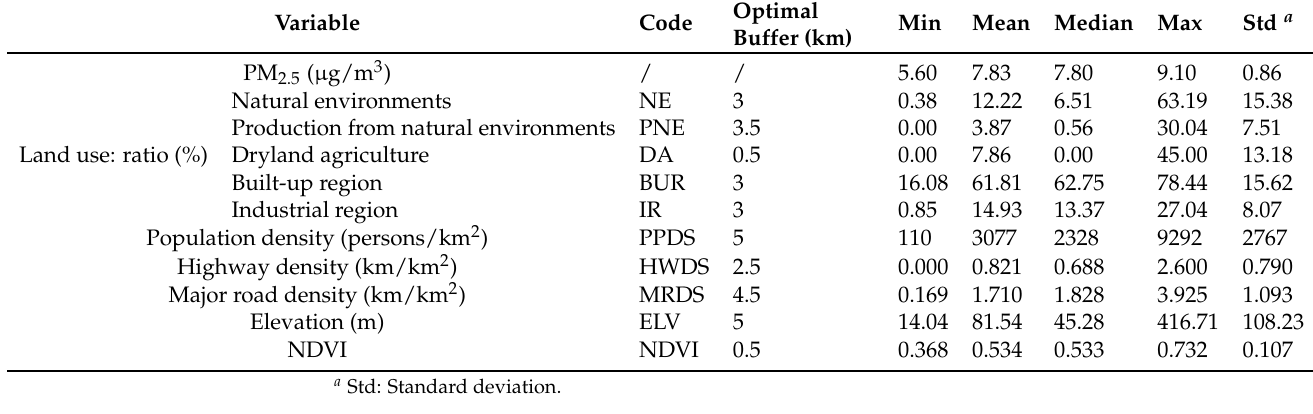
Table 1. Particulate matter observations and selected explanatory variables.